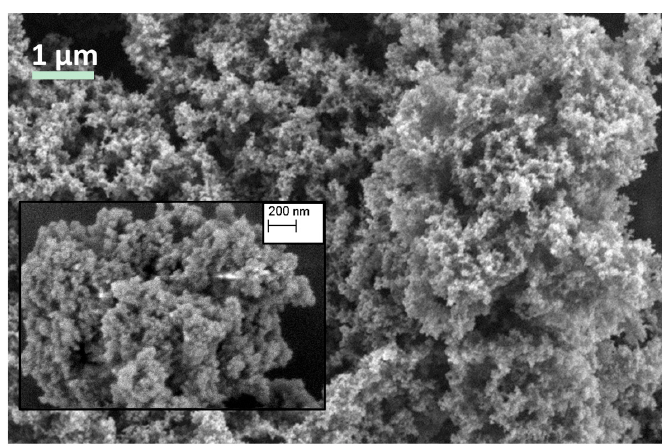
Figure 4. Microstructure of SA2 (magnification of image 10k× and of inset 24k×).